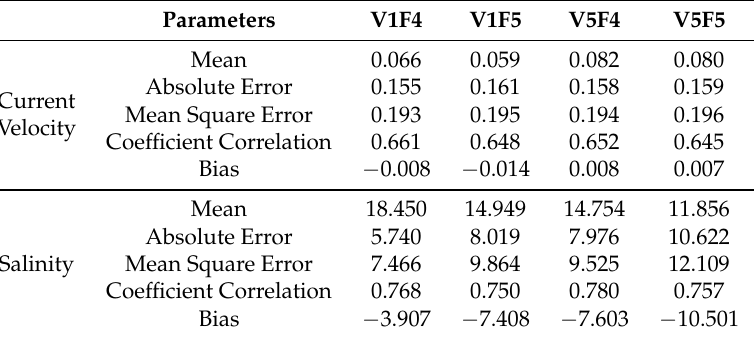
Table 2. Calibration